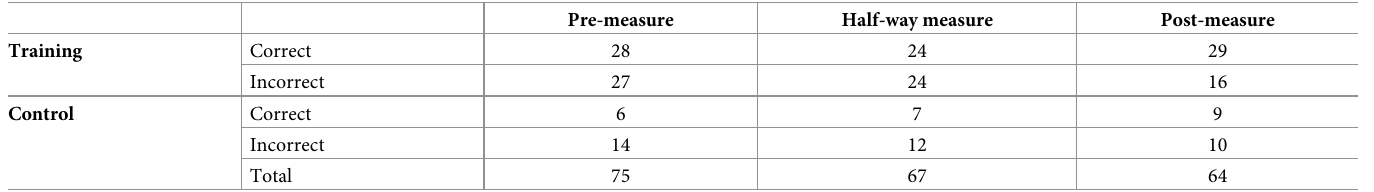
Table 1. Descriptive statistics of participants’ performance of the convergent visual imagination task at pre-measure, half-way measure and post-measure after checking